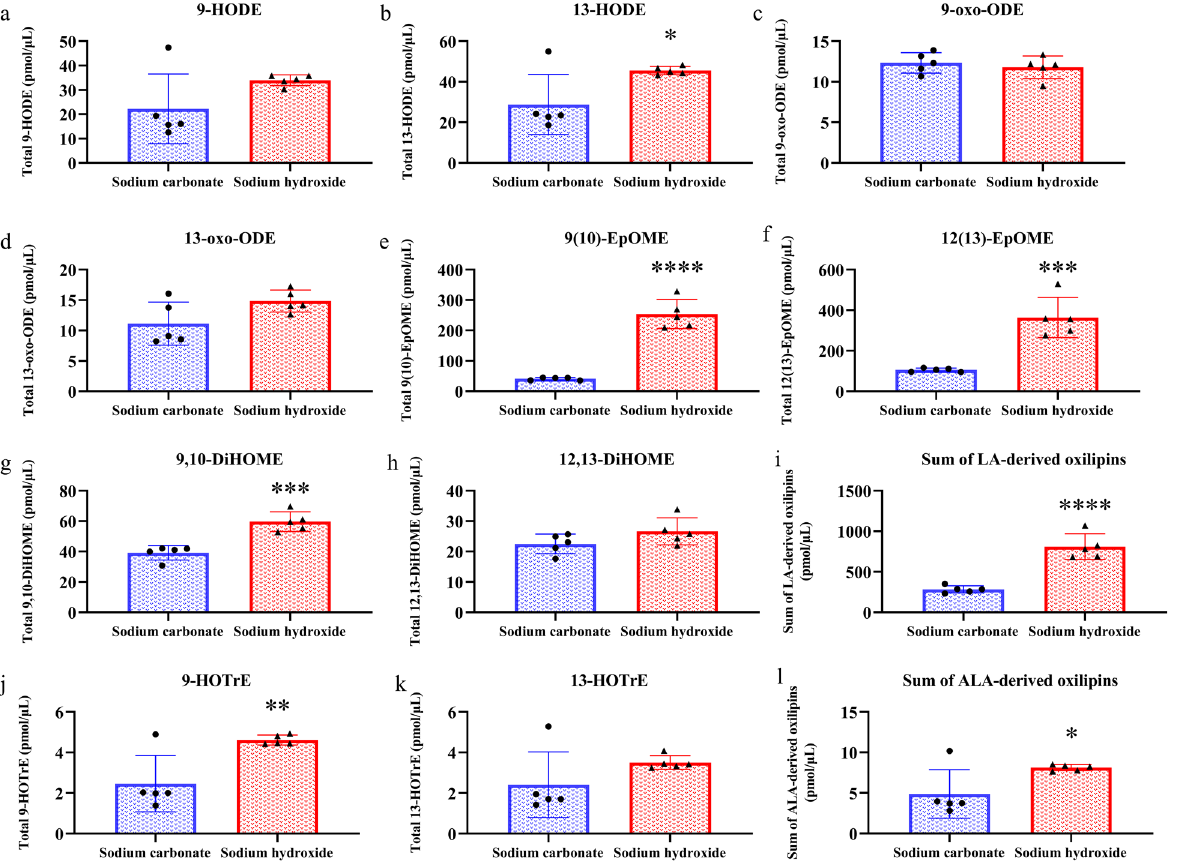
Fig. 2 Concentrations of total linoleic acid (LA)-derived and α -linolenic acid (ALA)-derived oxylipins in 1 µL soybean oil hydrolyzed with sodium carbonate or sodium hydroxide. Data are expressed at mean ± SD of n = 5 per base type. * p < 0.05; ** p < 0.01; *** p < 0.001; **** p < 0.0001 by unpaired t